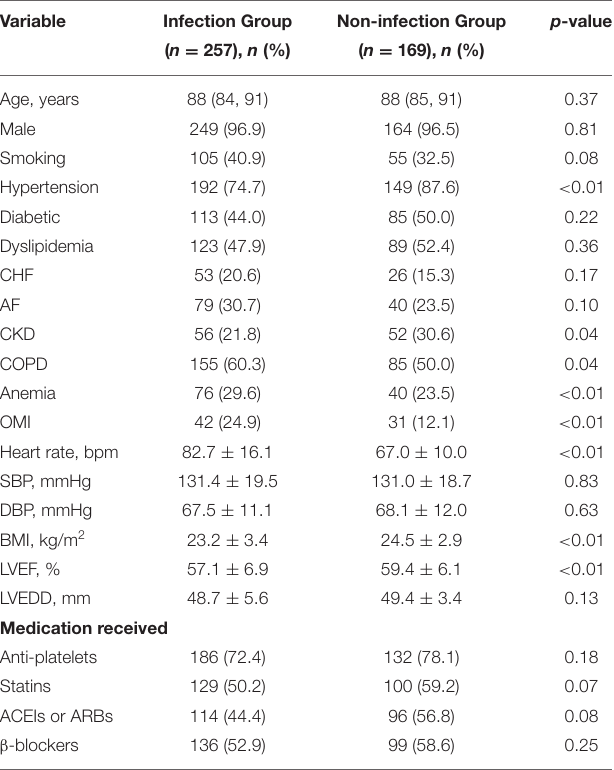
TABLE 1 | Characteristics of the infection and non-infection group at